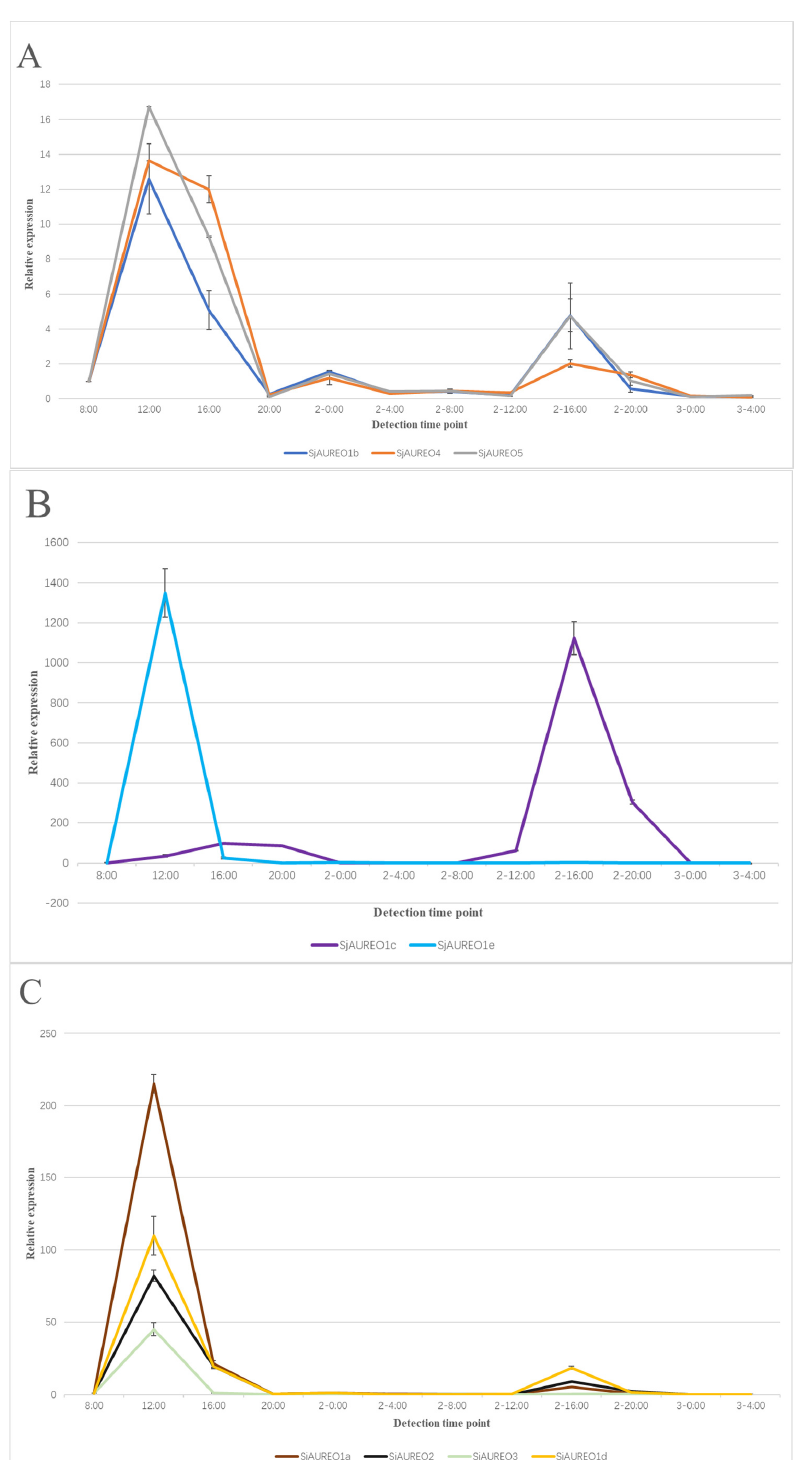
Figure 6. Expression map of Sj AUREO under periodic rhythm light. The abscissa represents each time node, and the ordinate represents the relative gene expression. Light cycle (8:00–16:00) and Dark cycle (16:00–8:00). 89% of Sj AUREO highly increased significantly ( p < 0.01) in the first four hours and highly decreased significantly ( p < 0.01) in the next four hours. Sj AUREO was divided into three groups based on the peak of different